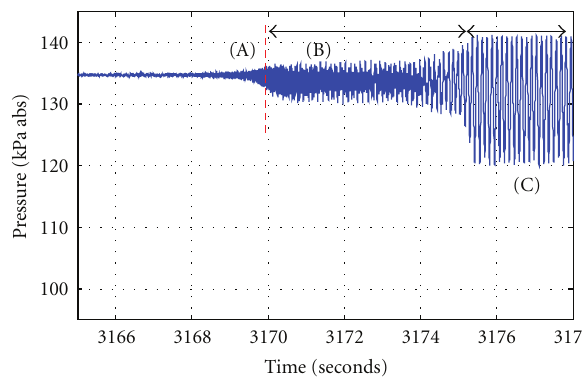
Figure 9: Pressure fluctuations in the discharge plenum during the onset of surge at 16,000 rpm: (A) instability initiation— observed audible sound change, (B) initial pressure fluctuations at a frequency near 21Hz, and (C) pressure fluctuations changed to a lower frequency near 7Hz as throttle valve closed further.